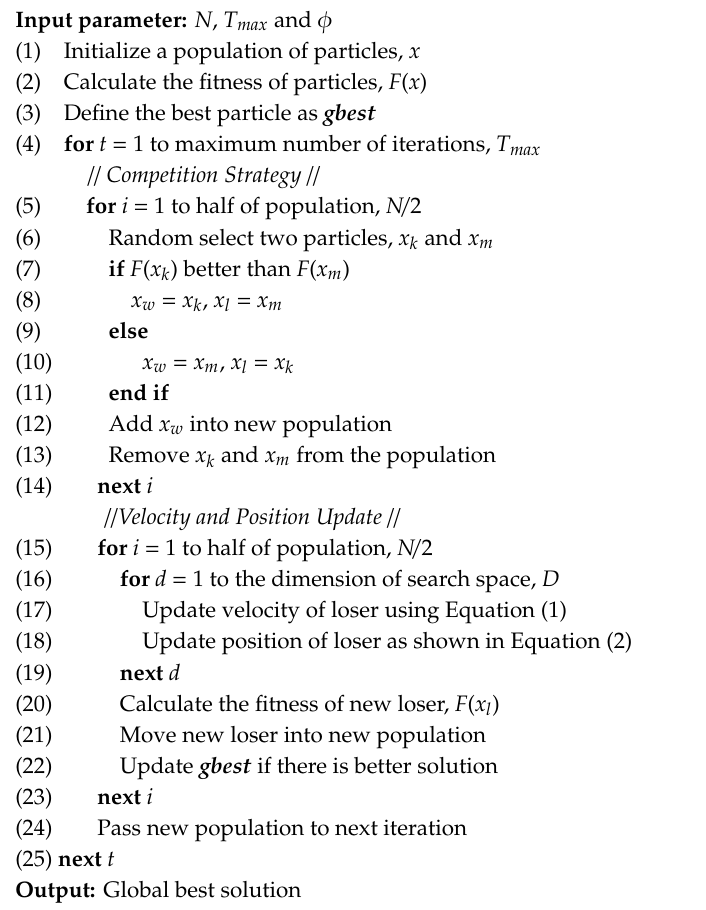
Algorithm 1. Competitive swarm